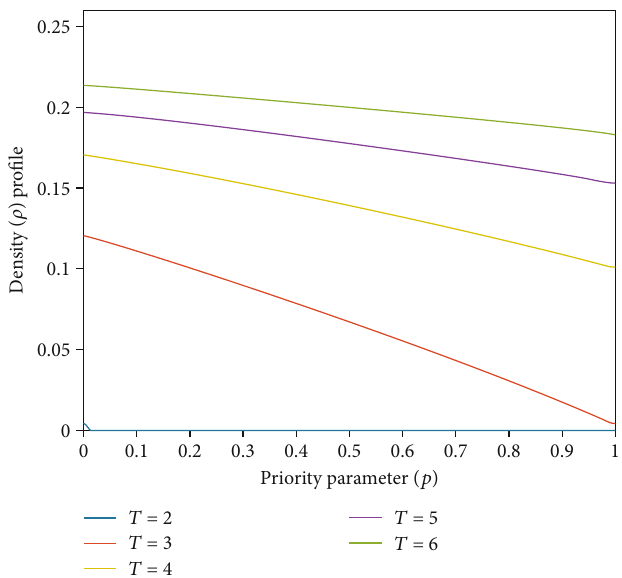
Figure 9: Evolution of density pro fi les on the entrance road and main lane of a roundabout versus priority parameters for time simulation T between 2 ≤ T ≤ 6